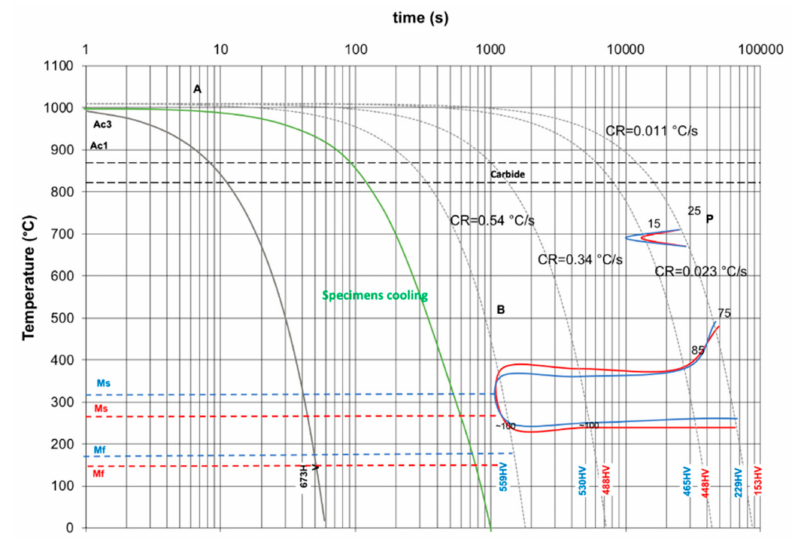
Figure 4. CCT diagrams of the considered steel (austenitization at 980 ◦ C, blue curve; austenitization at 1200 ◦ C, red curve) . Green cooling curve: first cooling undergone by all specimens reported in Table 2.